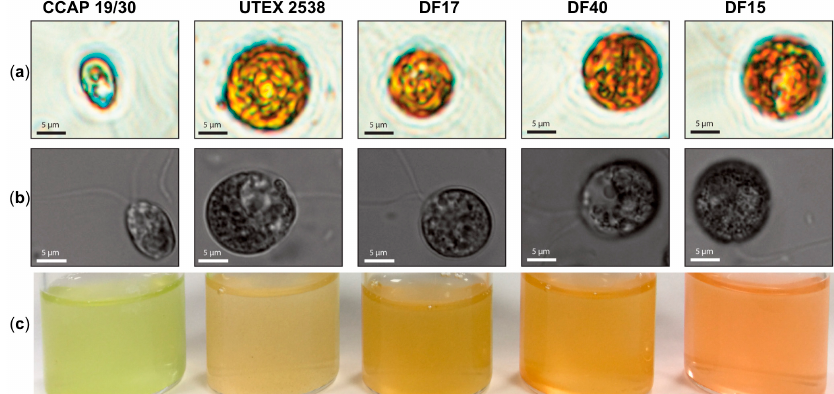
Figure 1. Microscopy observation of Dunaliella cells and photographs of stationary phase cultures of CCAP 19/30, UTEX 2538, DF17, DF40 and DF15 grown under a light intensity of 100~200 µmol·m − 2 ·s − 1 at 20 °C. ( a ) Microscopy photographs taken through a light microscope (Nikon Eclipse Ti-U) with a magnification of 600 × ; ( b ) Differential interference contrast (DIC) microscopy photographs taken through a confocal microscope (ZEISS LSM 880) with a magnification of 630 × . ( c ) Photographs of the cultures obtained for each Dunaliella strain grown under identical conditions.